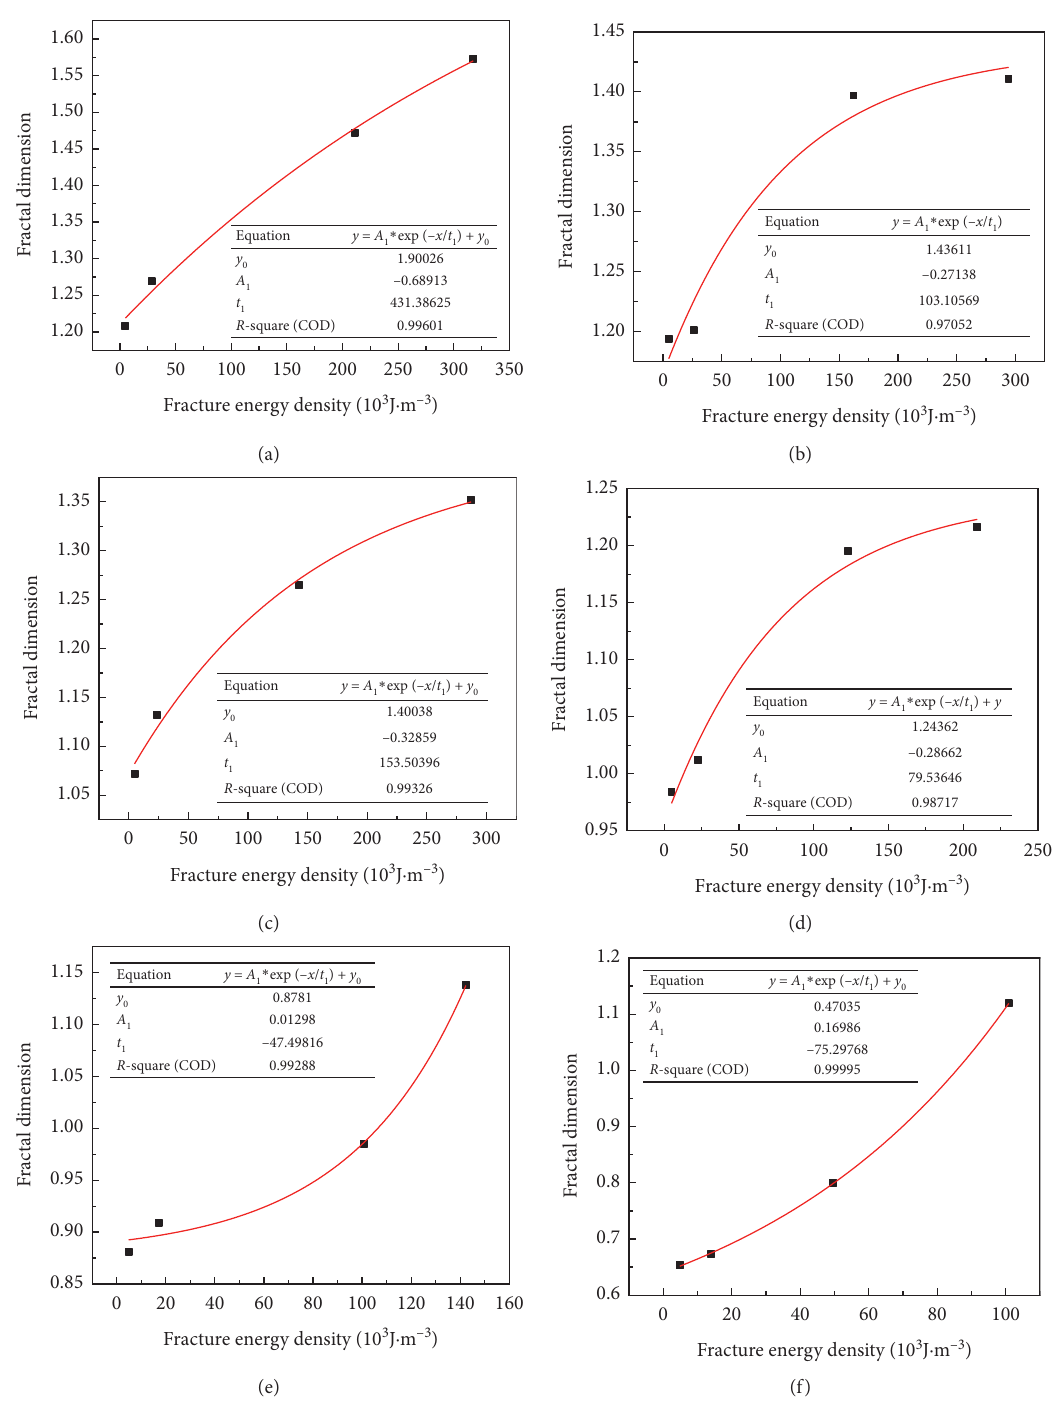
Figure 9: The relationship between fractal dimension and fracture energy density under confining pressure, (a) 0.7 MPa, (b) 0.86 MPa, (c) 1.0 MPa, (d) 1.15 MPa, (e) 1.3 MPa, and (f) 1.45